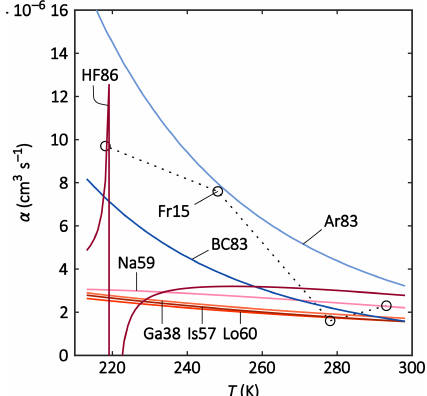
Figure 3. Parameterisations and theories (solid lines) and labora- tory data (circles; dotted lines to guide the eye) of the recombina- tion coefficient α versus T for the temperature range of 213–298K. The meanings of the abbreviated labels are listed in Table